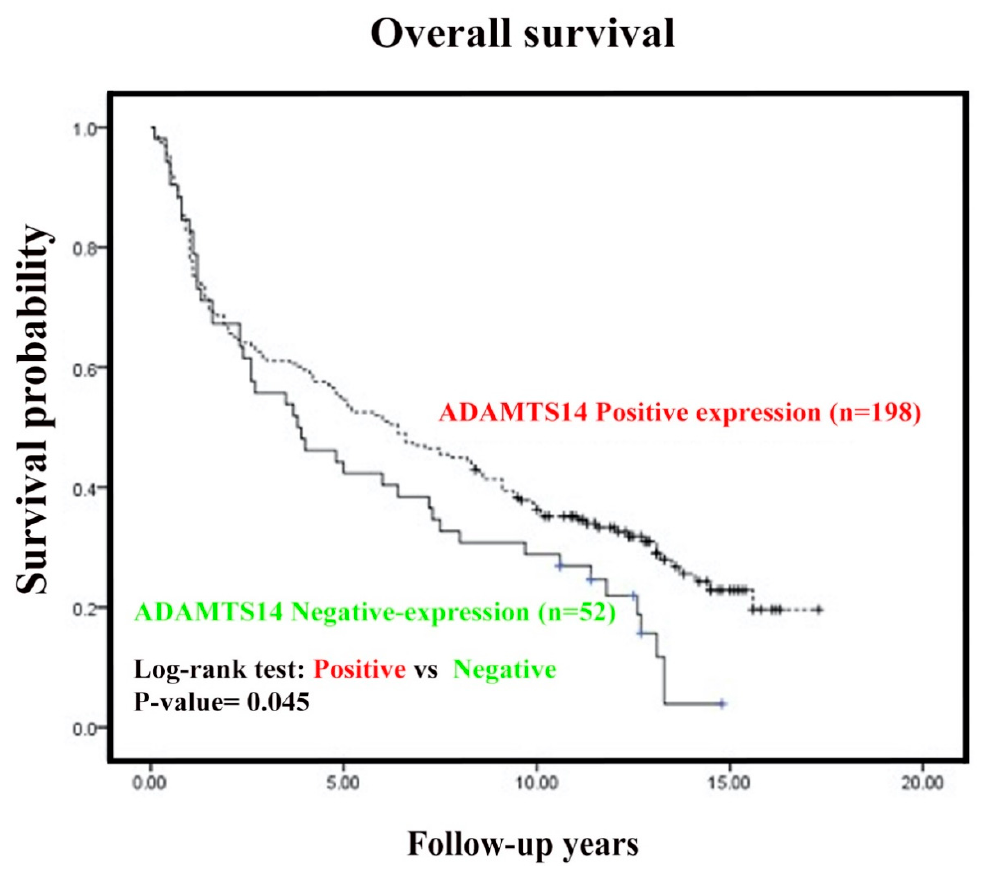
Figure 2. Influence of ADAMST14 expression on Kaplan–Meier survival curves among OSCC patients. Kaplan–Meier overall survival curves revealed survival differences between OSCC patients with positive cytoplasmic expression of ADAMTS14 and negative cytoplasmic expression of ADAMTS14 was also calculated using the log-rank tests for the homogeneity of Kaplan–Meier curves.